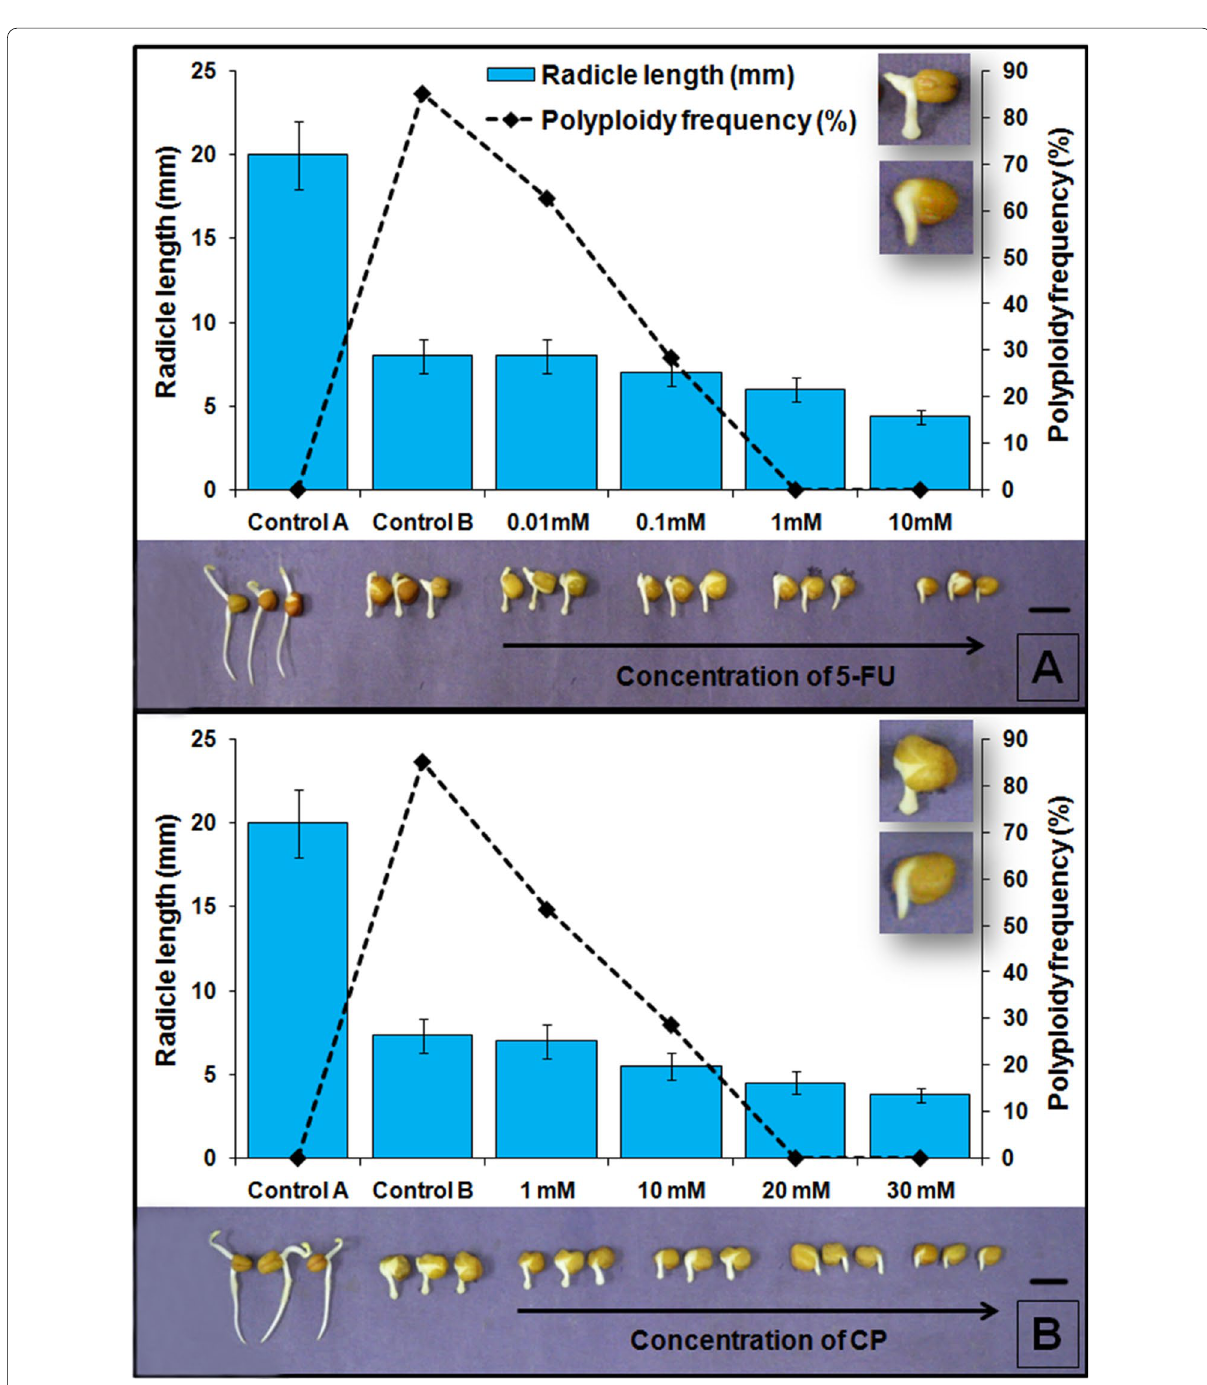
Fig. 2 Assessment of radicle length and frequency of polyploid cells treated with colchicine followed by different concentrations of ( A ) 5-fluorouracil and ( B ) cyclophosphamide. [Control B showing distinct bulging of root tips, other treatments decrease in bulging tendency of root tips from lower to higher concentrations of 5-FU and CP]. Scale bar 10 =